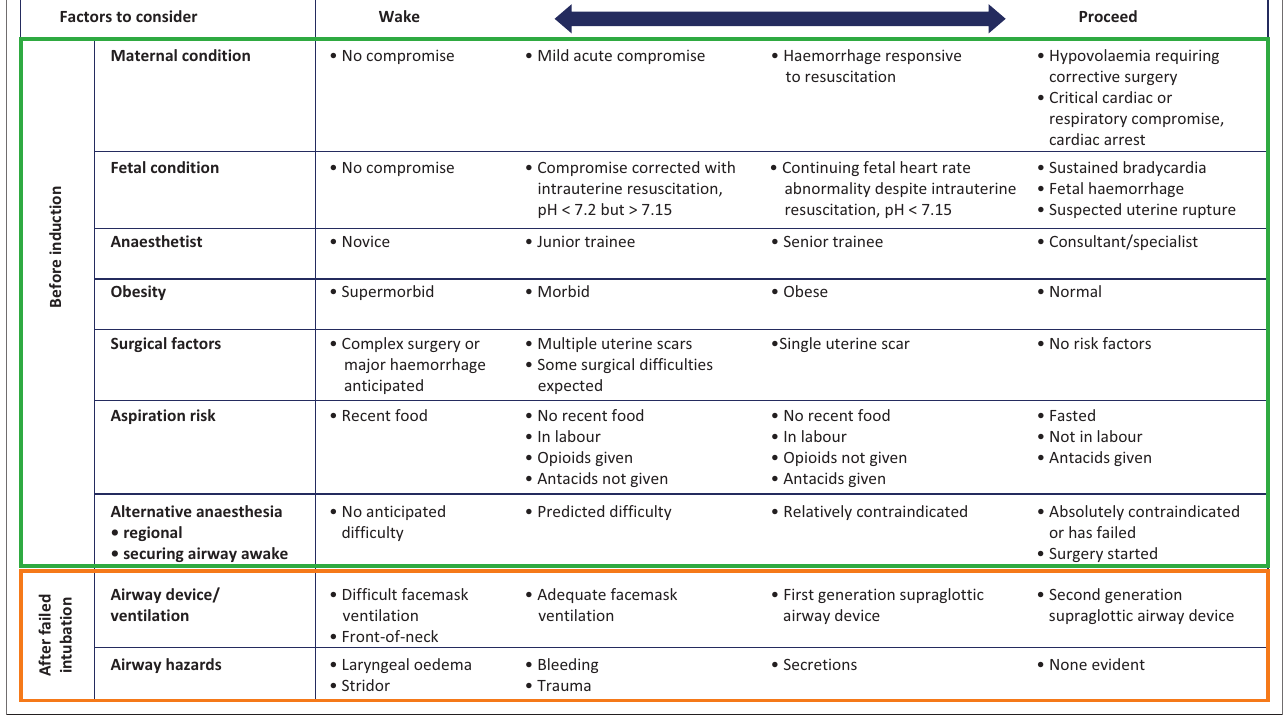
FIGURE 7: Wake or proceed with surgery, factors to